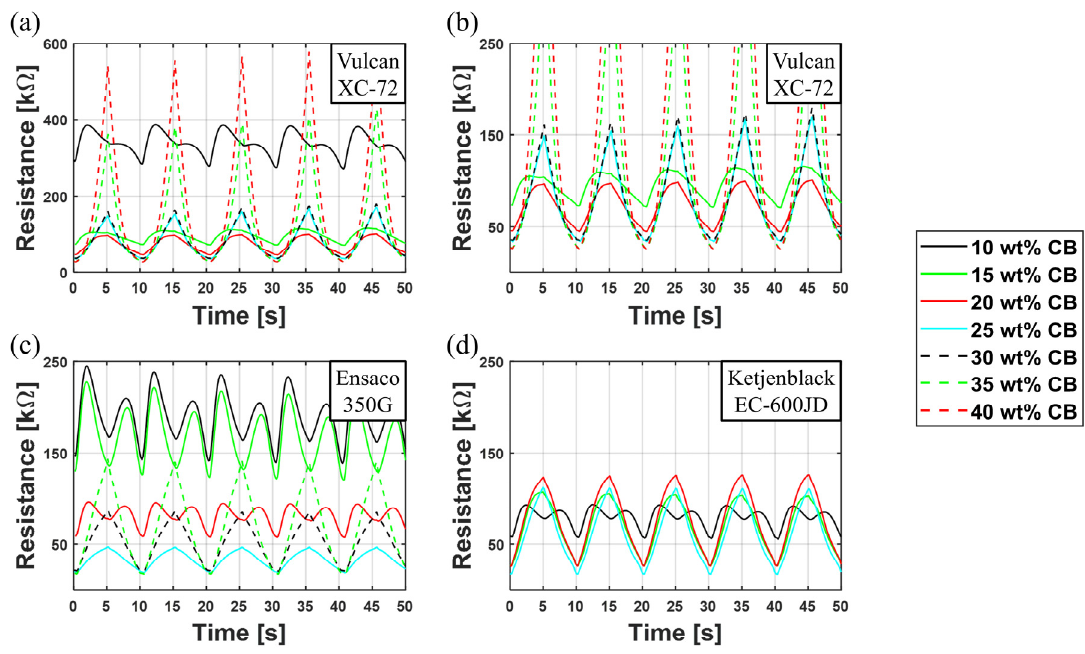
Figure 5. Influence of the used CB and the CB to silicone ratio on the electrical resistance: ( a , b ) re- sistance over time with different scaling for Vulcan XC-72; ( c ) resistance over time for Ensaco 350G ( d ) resistance over time for Ketjenblack EC-600JD.